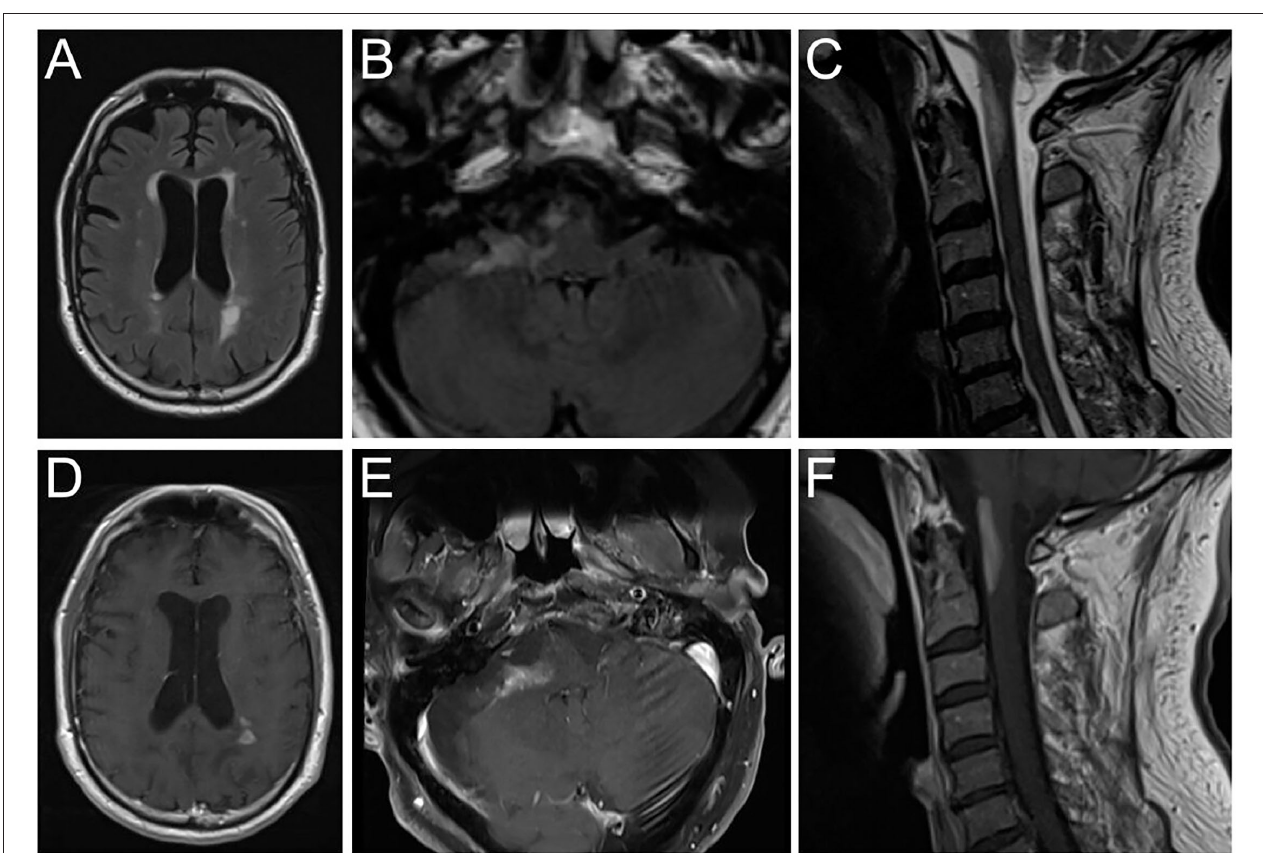
FIGURE 1 | Brain magnetic resonance imaging showing FLAIR hyperintense lesions (A–C) and T1 contrast-enhancement (D–F) in the periventricular white matter (A,D) , right cerebellar peduncle (B,E) and medulla oblongata/upper cervical spinal cord (C,F) . FLAIR, Fluid attenuated inversion recovery. further improved until 1 month after plasma exchange (three months after